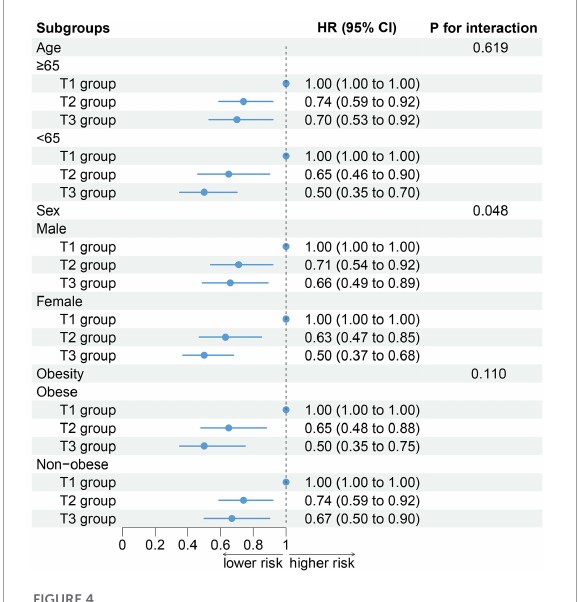
FIGURE4 The association between advanced lung cancer inflammation index (ALI) and all-cause mortality by selected